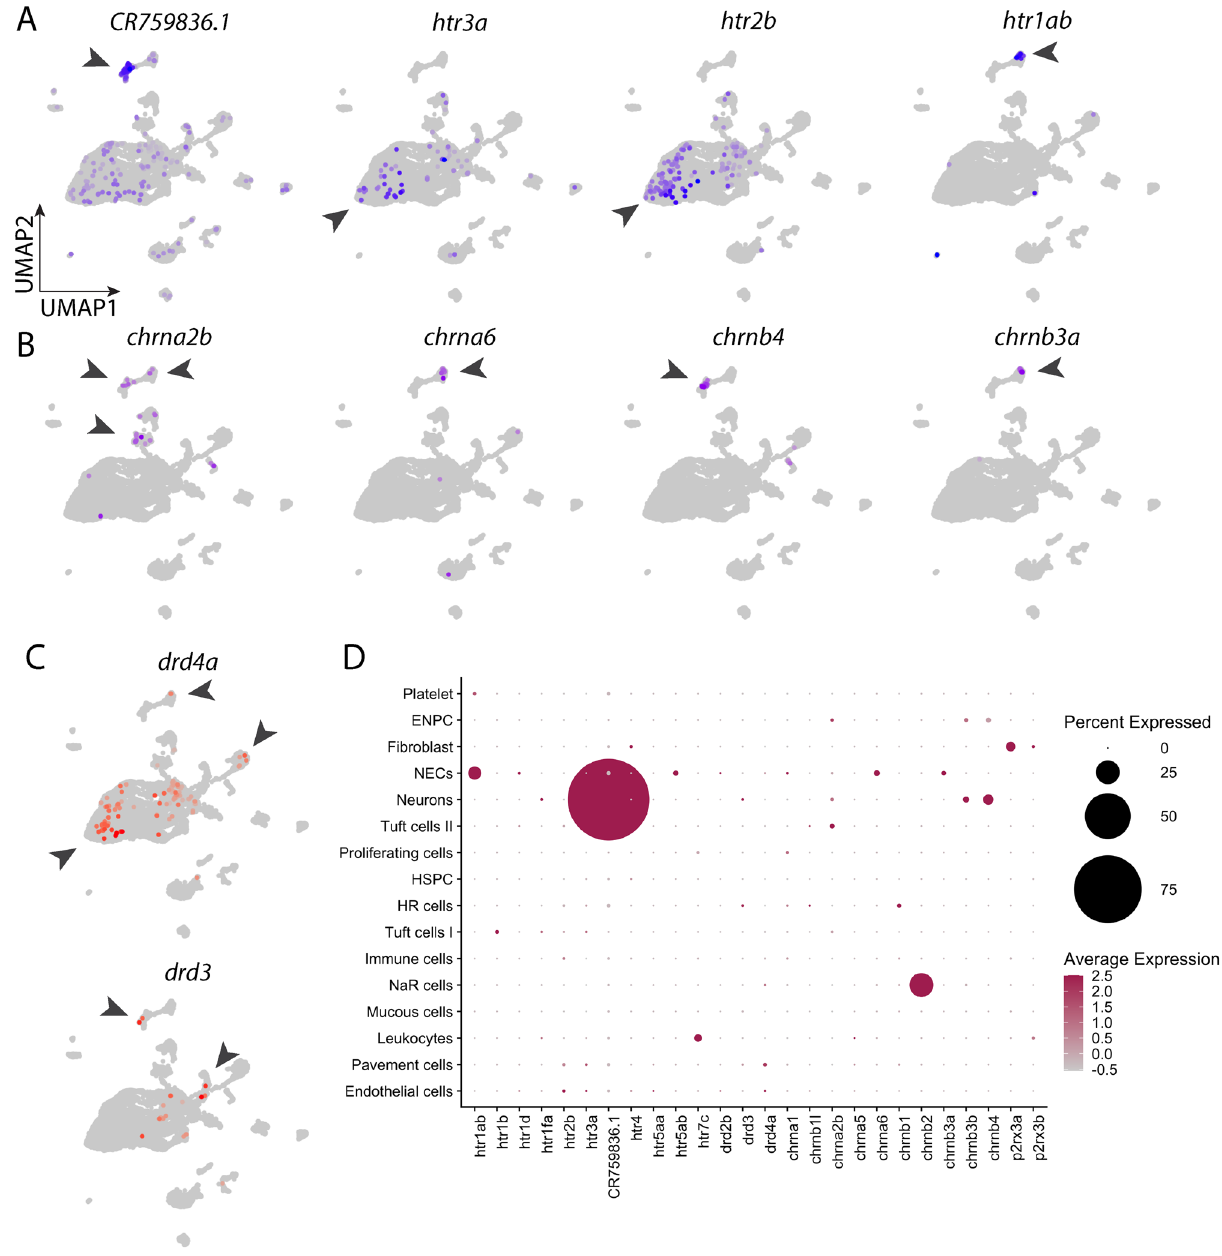
Figure 5. Expression of neurotransmitter receptors in the gill cell atlas. ( A ) UMAP plots showing the distribution of selective 5-HT receptor subunits in all cell populations. Arrowheads indicate cell clusters with significant gene expression. ( B ) UMAP plots showing distribution of selective cholinergic receptor subunits in all cell populations. ( C ) UMAP plots showing distribution of selective DA receptors in all cell populations. ( D ) Dotplot of 5-HT, cholinergic, dopaminergic and purinergic neurotransmitter receptor subunit expression in 16 gill cell clusters. Colour intensity is proportional to the level of expression, and the size of dot indicates the percent of cells showing gene expression in the cell cluster. All dots were manually enlarged to make receptors of lower expression more visible. Scales are provided for percent and average expression. See text and Tables 1 and 2 for gene